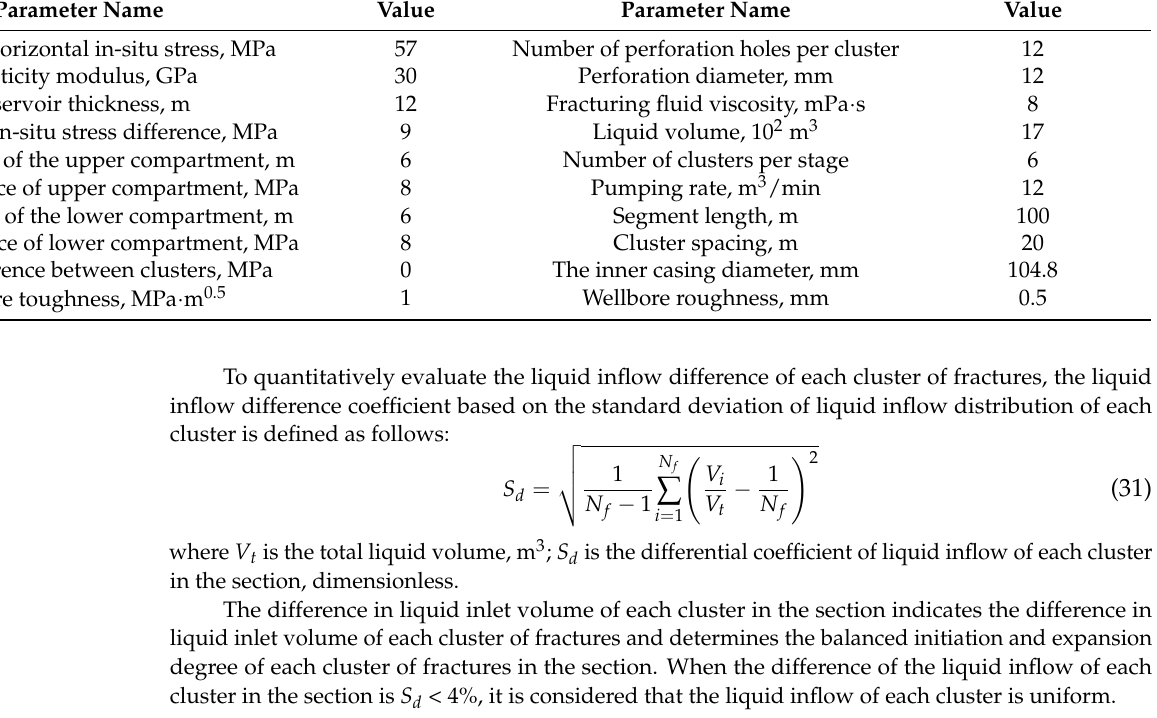
Table 2. Basic simulation Table 2. basic simulation parameters.